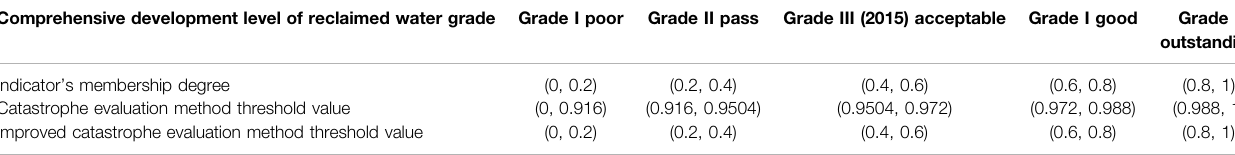
TABLE 5 | Standards for grade classi fi cation in relation to comprehensive development level of reclaimed water. Comprehensive development level of reclaimed water grade Grade I poor Grade II pass Grade III (2015) acceptable Grade I good